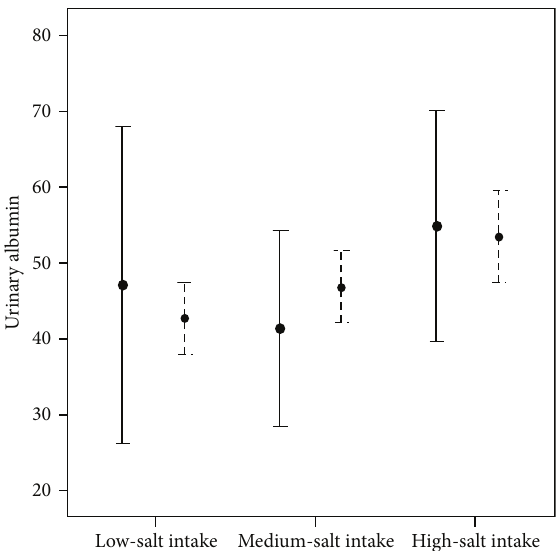
Figure 1: Mean urine albumin level in different salt intake groups.